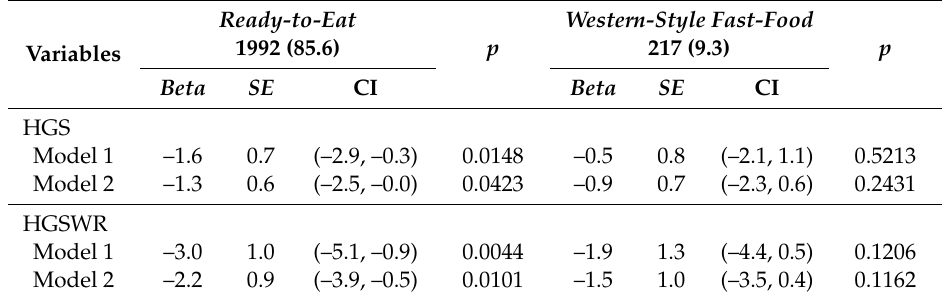
Table 4. Multivariate linear regression analysis of the association between dietary patterns and HGS of 10–18-year-old children and